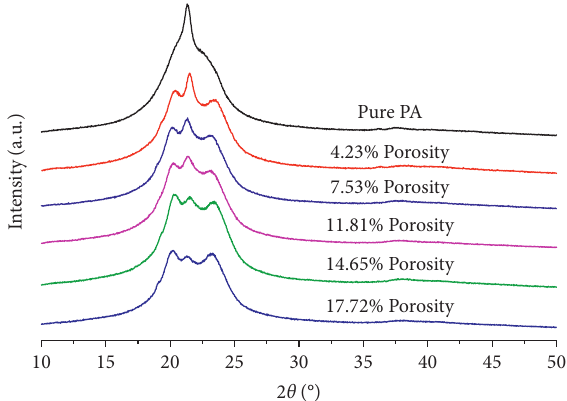
Figure 6: XRD patterns of modified fibers with different porosities.